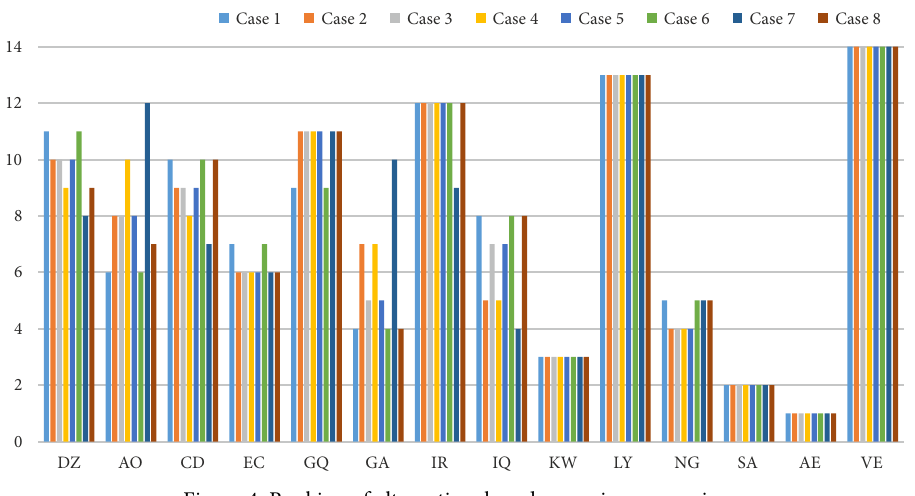
Figure 4. Ranking of alternatives based on various scenarios